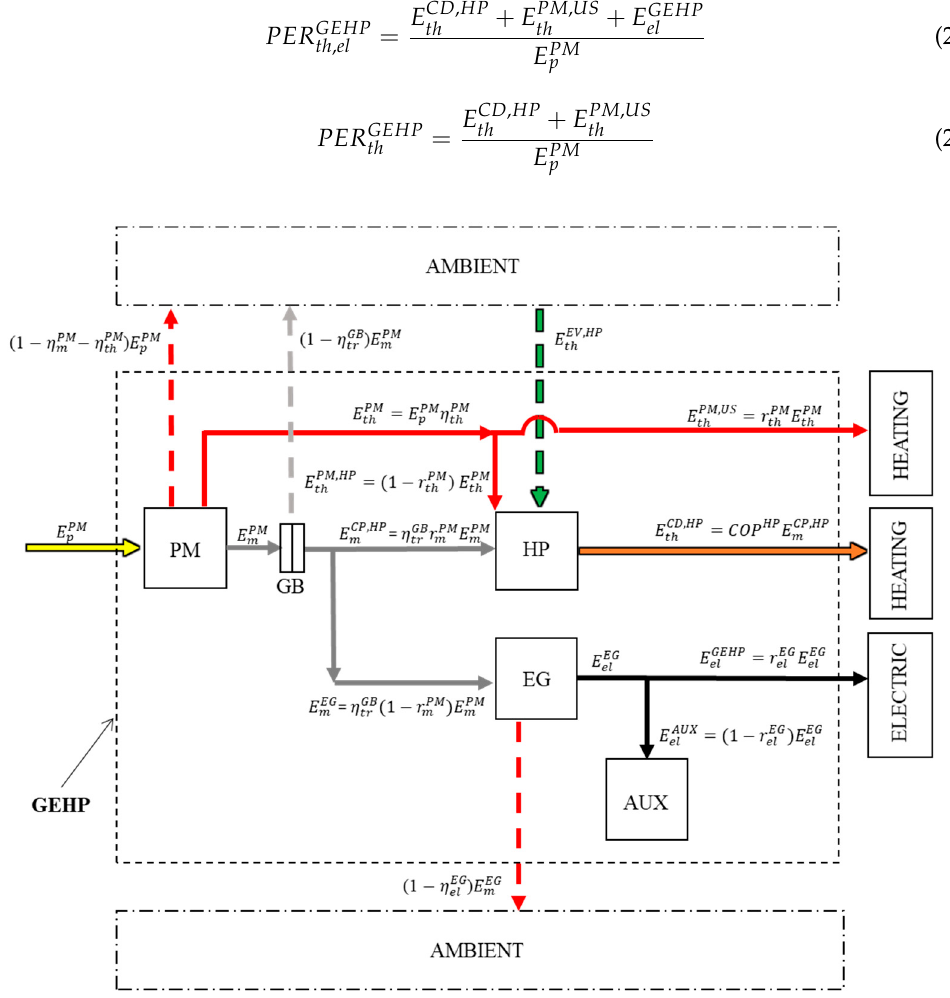
Figure 17. GEHP including an EG in cooling operating mode with indirect engine heat recovery.